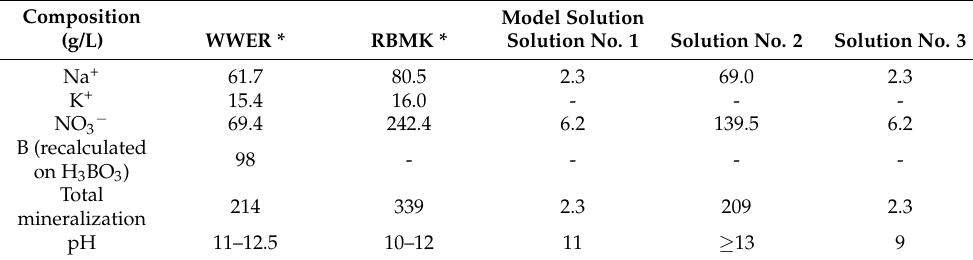
Table 6. Compositions of simulate solutions used in the present